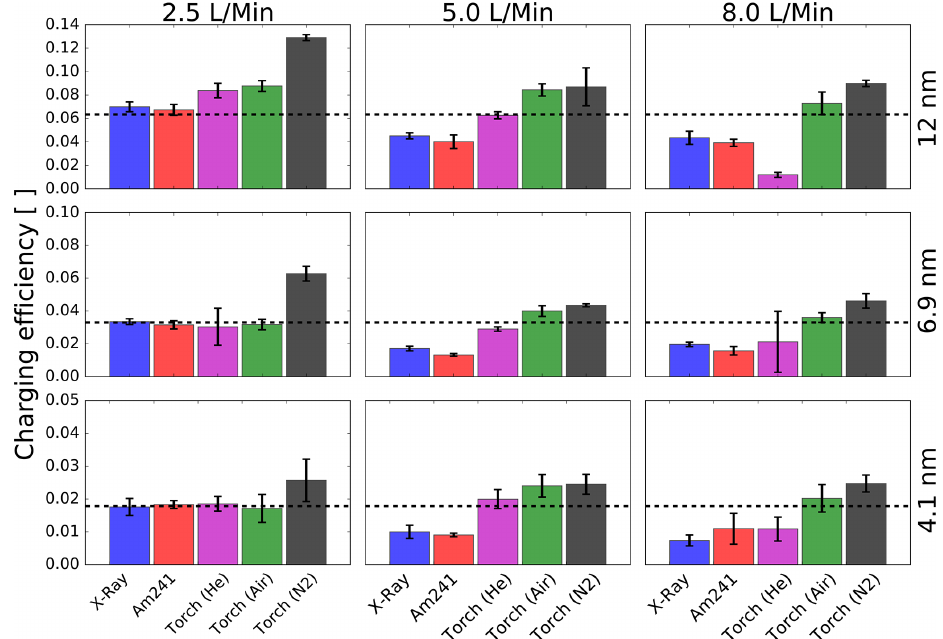
Figure 9. Measured charging efficiencies for the different aerosol chargers and aerosol flow rates for negatively charged Ag particles with mobility diameters of 12, 6.9 and 4.1nm. The dotted black line represents the theoretical charging efficiency according to Wiedensohler (1988) for the three different mobility